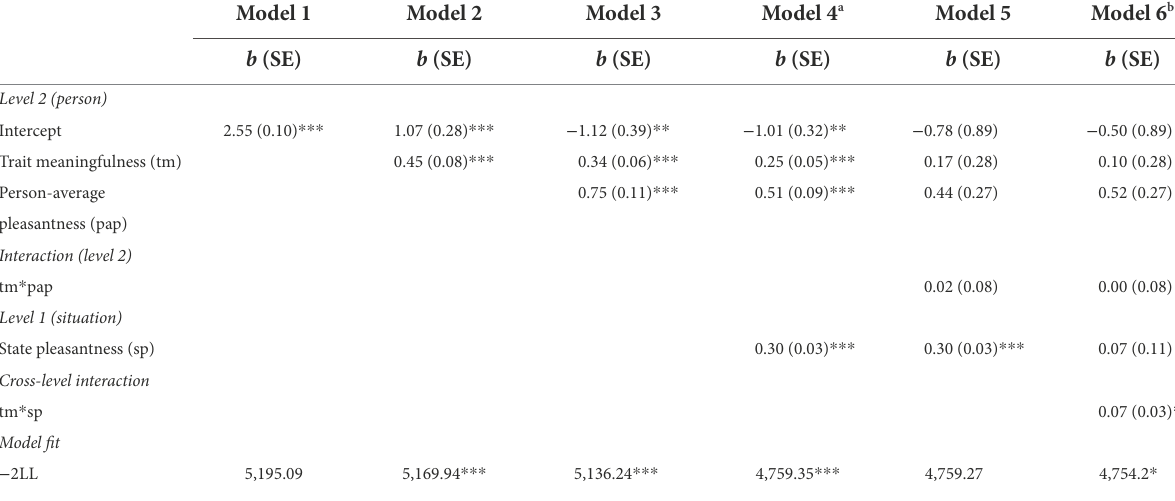
TABLE 6 Two-level linear regression results; outcome variable: state meaningfulness.